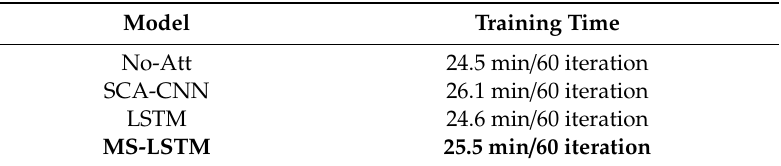
Table 12. Comparison of training time of each